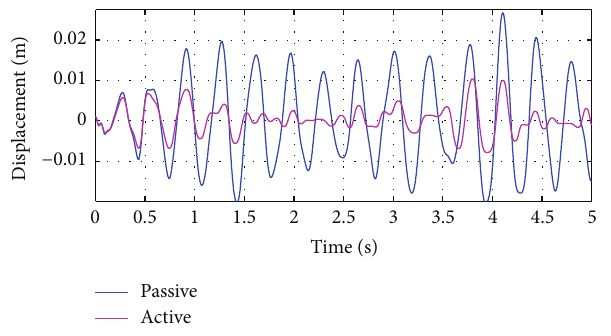
Figure 6: The suspension deflection, 𝑧